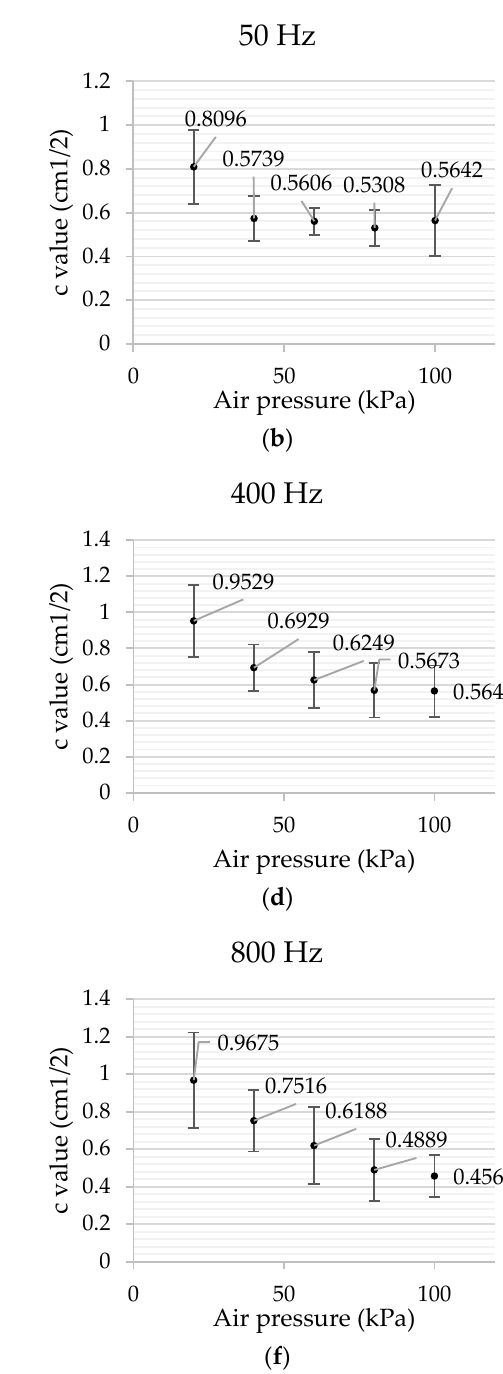
Figure 7. Coefficients b δ and c resulting from the fitting of the experimental data to the generalized Peek’s law with 95% confidence bounds. ( a ) b δ coefficient values at 50 Hz. ( b ) c coefficient values at 50 Hz. ( c ) b δ coefficient values at 400 Hz. ( d ) c coefficient values at 400 Hz. ( e ) b δ coefficient values at 800 Hz. ( f ) c coefficient values at 800